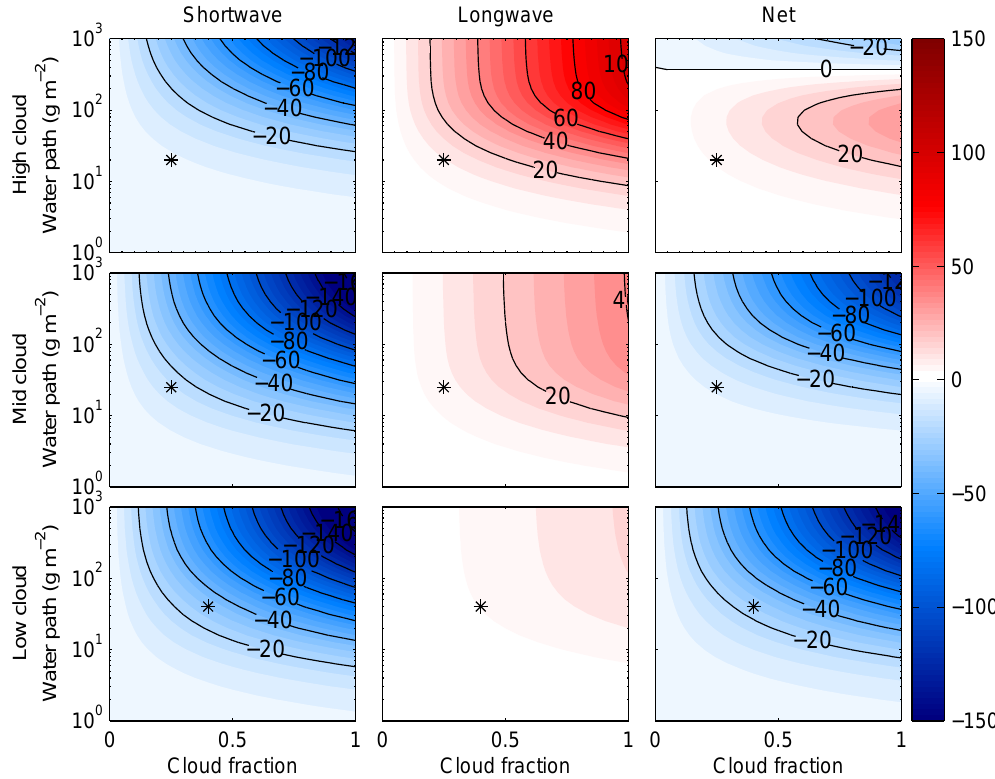
Fig. 11. Cloud radiative forcing with cloud fraction and water path relative to no cloud in that layer. For each cloud layer, these properties are varied whilst the clouds in other layers remain fixed at the case study values, marked ( S ). Particle sizes, ice/water ratio and height are as case study. Colour/contour scale is in Wm − 2 . For comparison, resolution of the late Archean FYSP would require a forcing of approximately 50Wm − 2